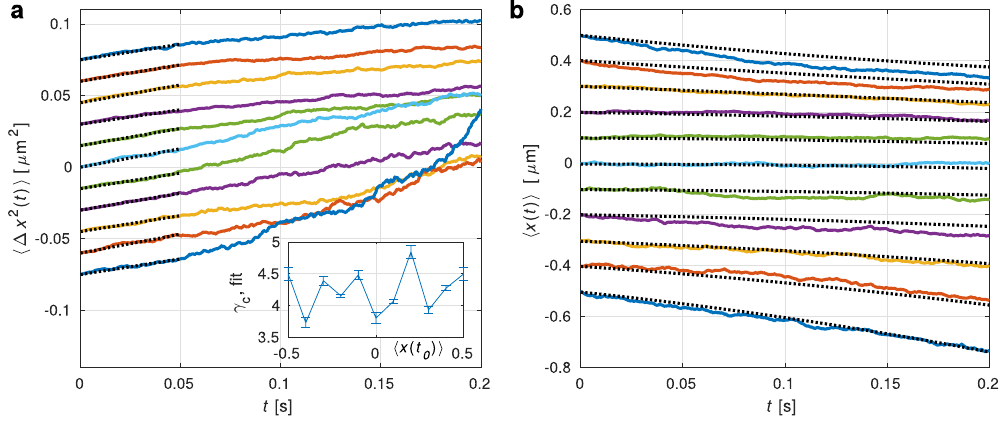
Figure 3. Short time evolution of variance 〈 Δ x 2 ( t ) 〉 and the mean particle position 〈 x ( t ) 〉 . The initial positions of particle trajectories 〈 x (0) 〉 were equally placed at 0.5, 0.4, …, − 0.5 μ m (from bottom to top). ( a ) Short time evolution of variance 〈 Δ x 2 ( t ) 〉 . Thick curves show experimental data (vertically displaced with respect to each other, offset 0.15 × 〈 x (0) 〉 ) and thin dotted curves correspond to equation (5) fitted to experimental data with the only fitting parameter γ c (see Methods). Inset shows γ c obtained this way for initial particle position. ( b ) Short time evolution of the mean particle displacement from the starting location 〈 x (0) 〉 . Thick curves show experimental data and thin lines are obtained using equation (4) with already obtained values of γ and κ